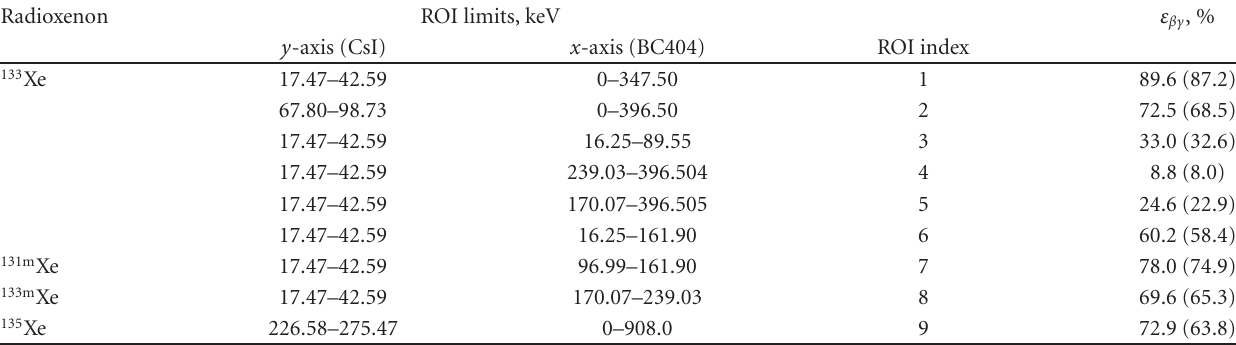
Table 1: The coincidence detection e ffi ciencies ( ε βγ ) of the di ff erent X-rays and gamma rays of xenon radioisotopes by Geant4 modeling.